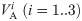
Relationships ‘maximal uptake rate vs initial nutrient concentration’ and ‘biomass yield vs initial nutrient concentration’ observed for C. albicans growing on glucose.Left: relationships between the maximal uptake rate parameter V and the initial nutrient concentration N0 observed for C. albicans growing on glucose. Dots with error bars (estimated values ± SE, where SE might be obscured by values) represent optimal estimates for maximal uptake rate parameters VAi(i=1..3) obtained by fitting the model (2) to the experimental data on growth at the following initial glucose concentrations N0,i (i = 1..3): 0.025%, 0.5%, 1% (see S1 Text, Appendix B, B7 Fig and S1 Text, Appendix A, A7 Table), and a solid line is the optimal non-linear least-squares fit of the function (8) to the plotted data. Right: relationships between the yield parameter Y and the initial nutrient concentration N0 observed for C. albicans growing on glucose. Dots with error bars (estimated values ± SE, where SE might be obscured by values) represent optimal estimates for yield parameters YAi(i=1..3) obtained by fitting the model (2) to the experimental data on growth at the following initial glucose concentrations N0,i (i = 1..3): 0.025%, 0.5%, 1% (see S1 Text, Appendix B, B7 Fig and S1 Text, Appendix A, A7 Table), and a solid line is the optimal non-linear least-squares fit of the function (3) to the plotted data.